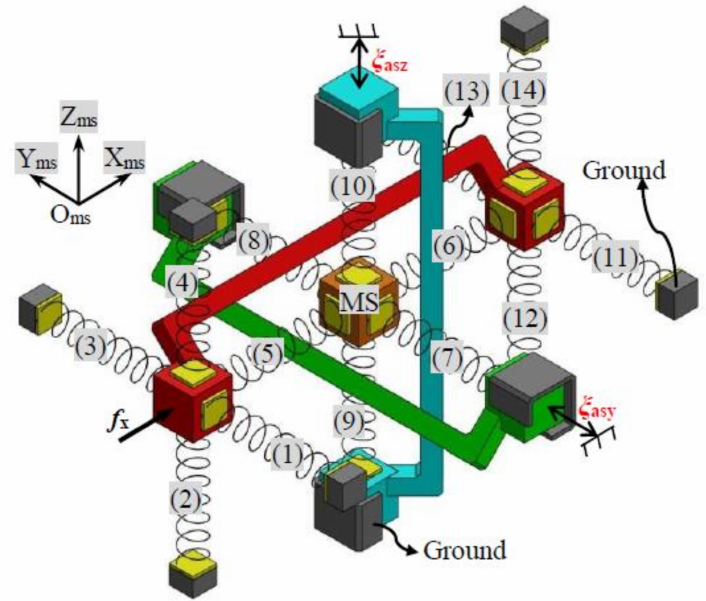
Figure 5. Simplified spring model of the symmetric XYZ CPM with illustrative force actuation along the X-axis (RL-X is red in color, RL-Y is green in color, and RL-Z is blue in